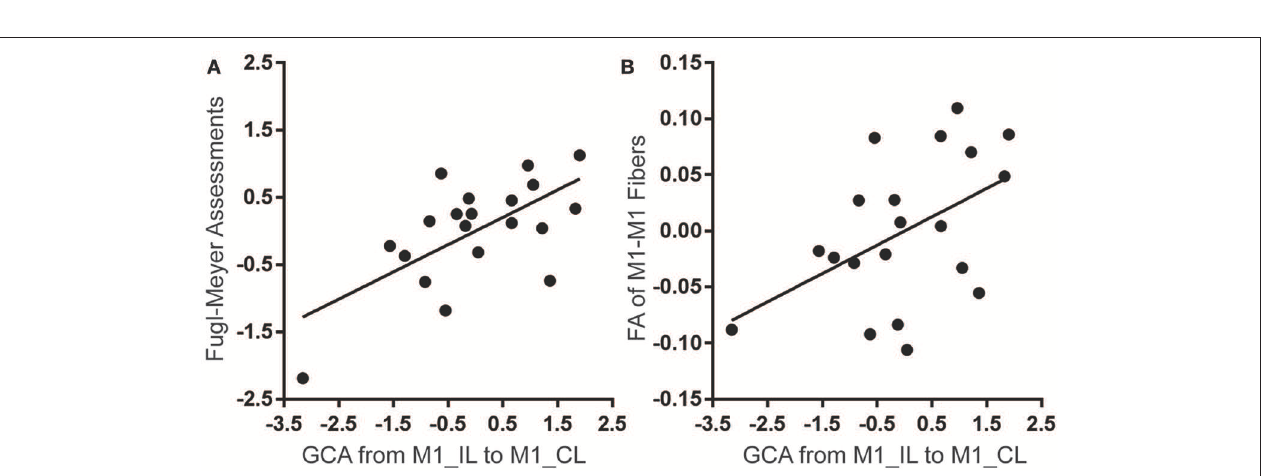
FIGURE 4 | Significant correlations of the effective connectivity from ipsilesional to contralesional M1 with FMA score (A) and FA value of M1-M1 anatomical connection (B) in stroke patients. The y-axes represent residues of upper-limb FMA score or FA values after controlling for the effects of age, sex, lesion volumes and post-stroke interval. CL, contralesional; FA, fractional anisotropy; FMA, Fugl-Meyer assessment; GCA, Granger causality analysis; IL, ipsilesional; and M1, primary motor